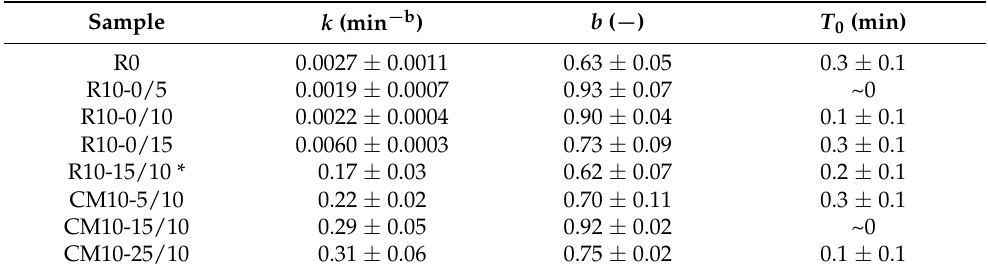
Table 3. Values of k , b , and T 0 parameters calculated according to the Weibull model for MLX samples. Sample